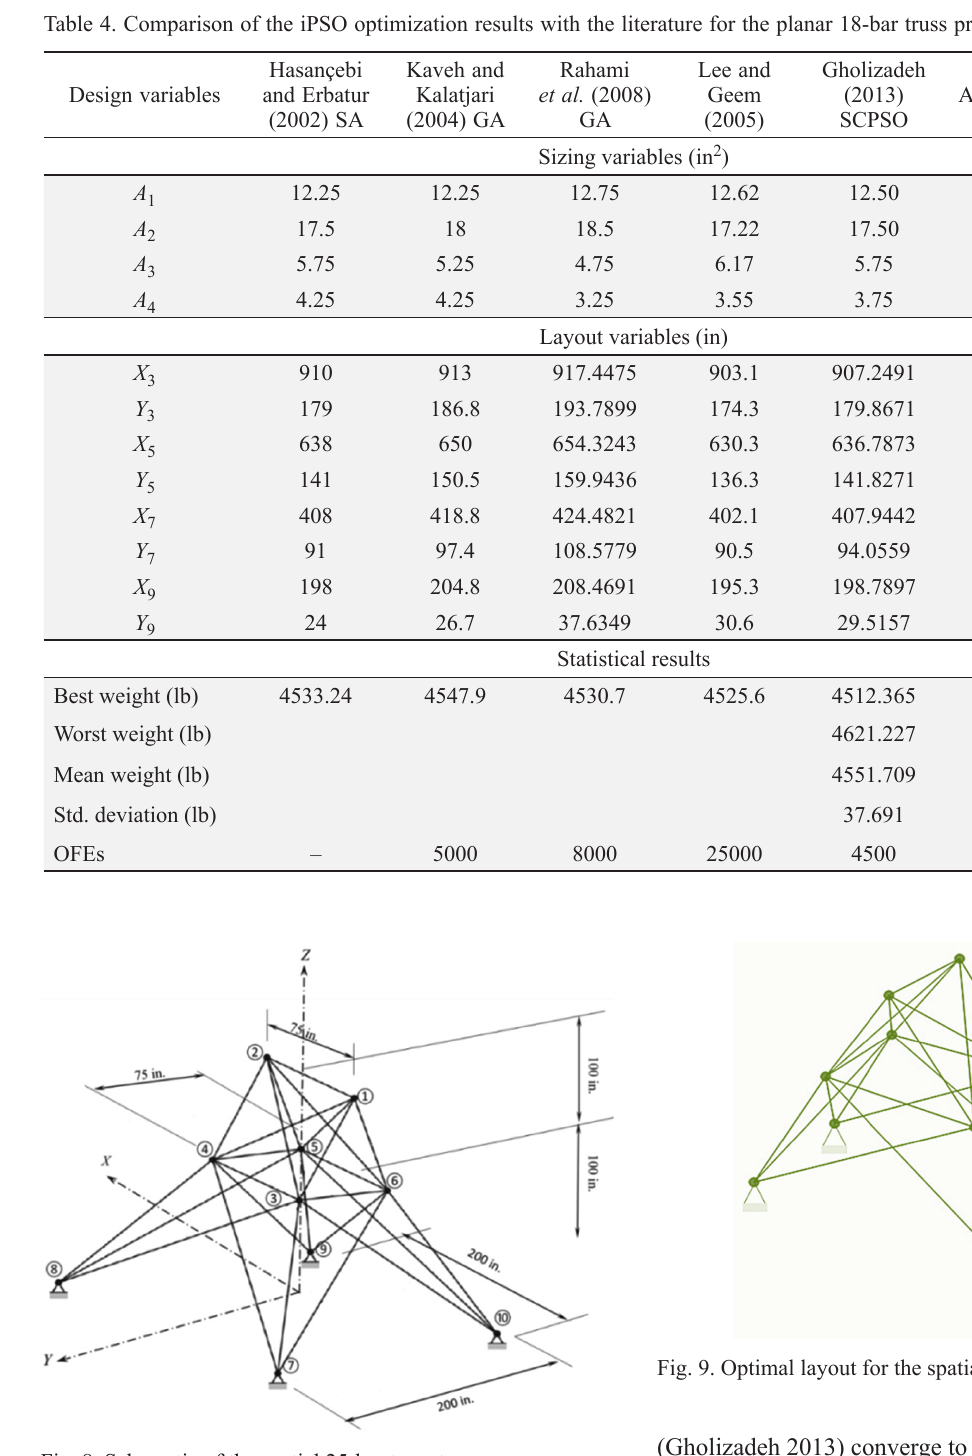
Fig. 8. Schematic of the spatial 25-bar truss tower